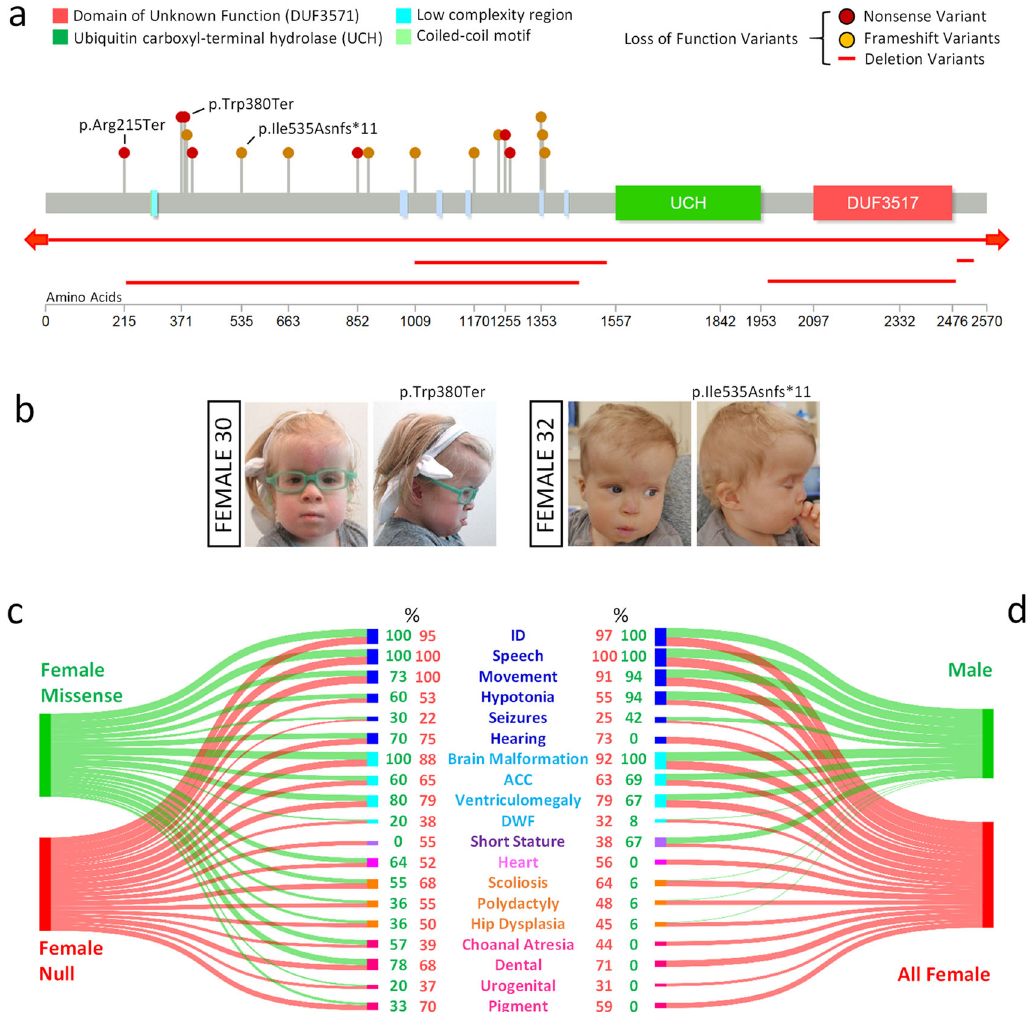
Fig. 5 Comparison of phenotypic features of females with different USP9X variant types and with males. a Location of bona fi de loss-of- function variants in individuals with USP9X -female syndrome. Three novel variants described in this study are annotated. b Images showing facial dysmorphisms of females affected by novel nonsense and frameshift USP9X variants. Note resemblance to individuals in Fig. 4c. c Comparison of clinical features of females with missense and single amino acid deletions ( n = 12) variants with females harbouring null alleles including all previously published cases and three novel cases identi fi ed in this study ( n = 23). Sankey plot highlights overlap across all features except short stature. d Comparison of clinical features of a combined female cohort ( n = 35) with phenotypes of all published males with likely pathogenic variants ( n = 16). Sankey plot highlights overlap across neurological features but not in other major female associated congenial phenotypes. Thickness of each stream is proportional to the percentage of cases with each feature, which is also provided numerically at the terminal